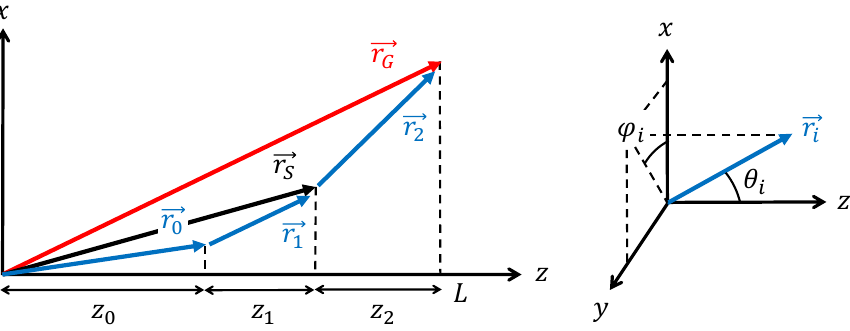
Figure 7 . Left: a two-dimensional illustration of the position vectors. Right: definitions of the angles θ i and ϕ i of ~r i in three dimensions. In both the figures, the z axis is taken to coincide with the LHC beam